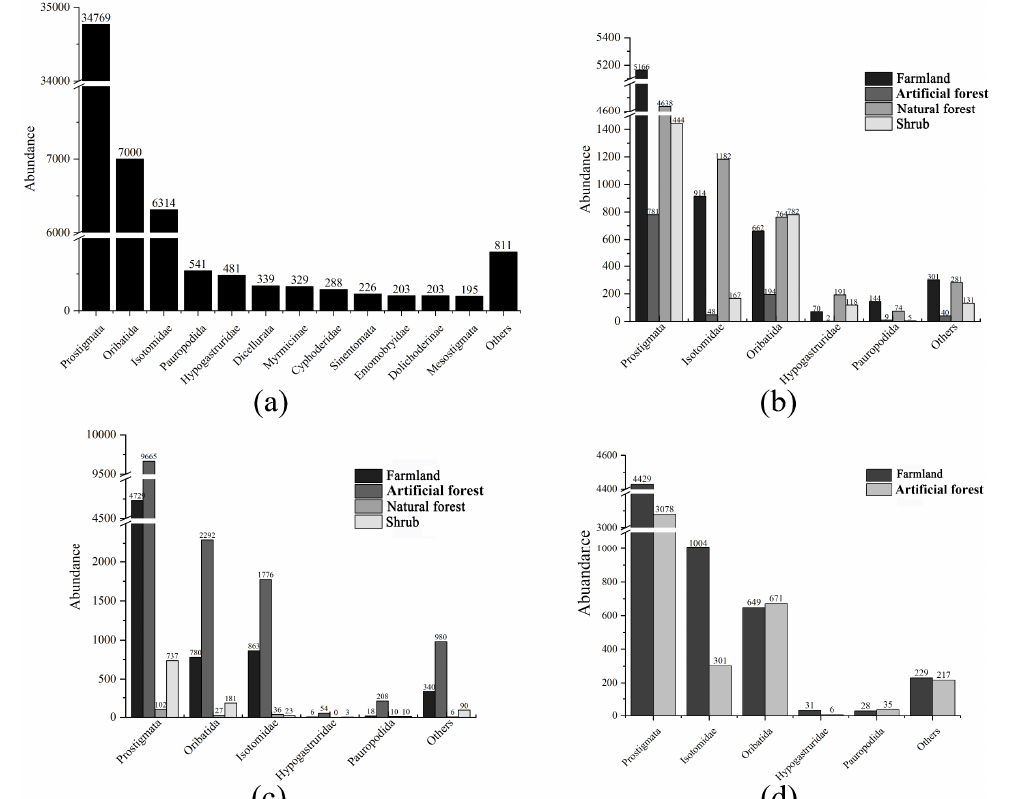
Figure 3. Composition of soil fauna under different landform types. ( a ) overall. ( b ) mountain landforms. ( c ) hilly landforms. ( d ) plain landforms.